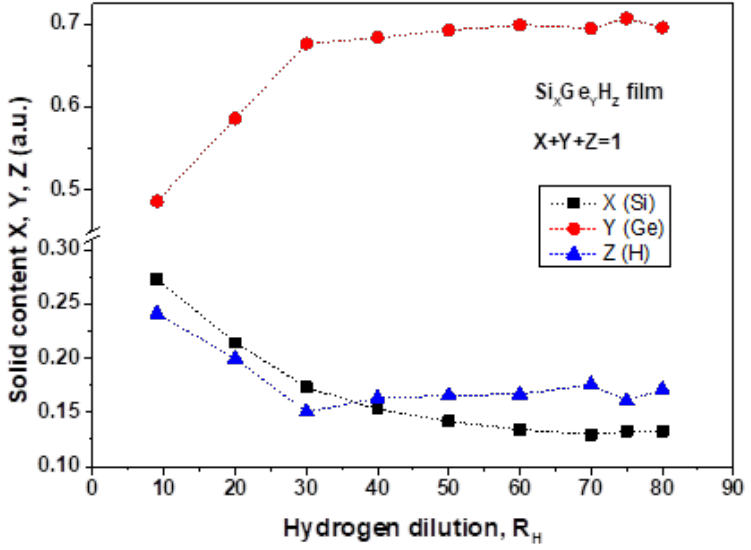
Figure 3. Solid content composition for Si X Ge Y :H Z films as a function of the hydrogen dilution rate.